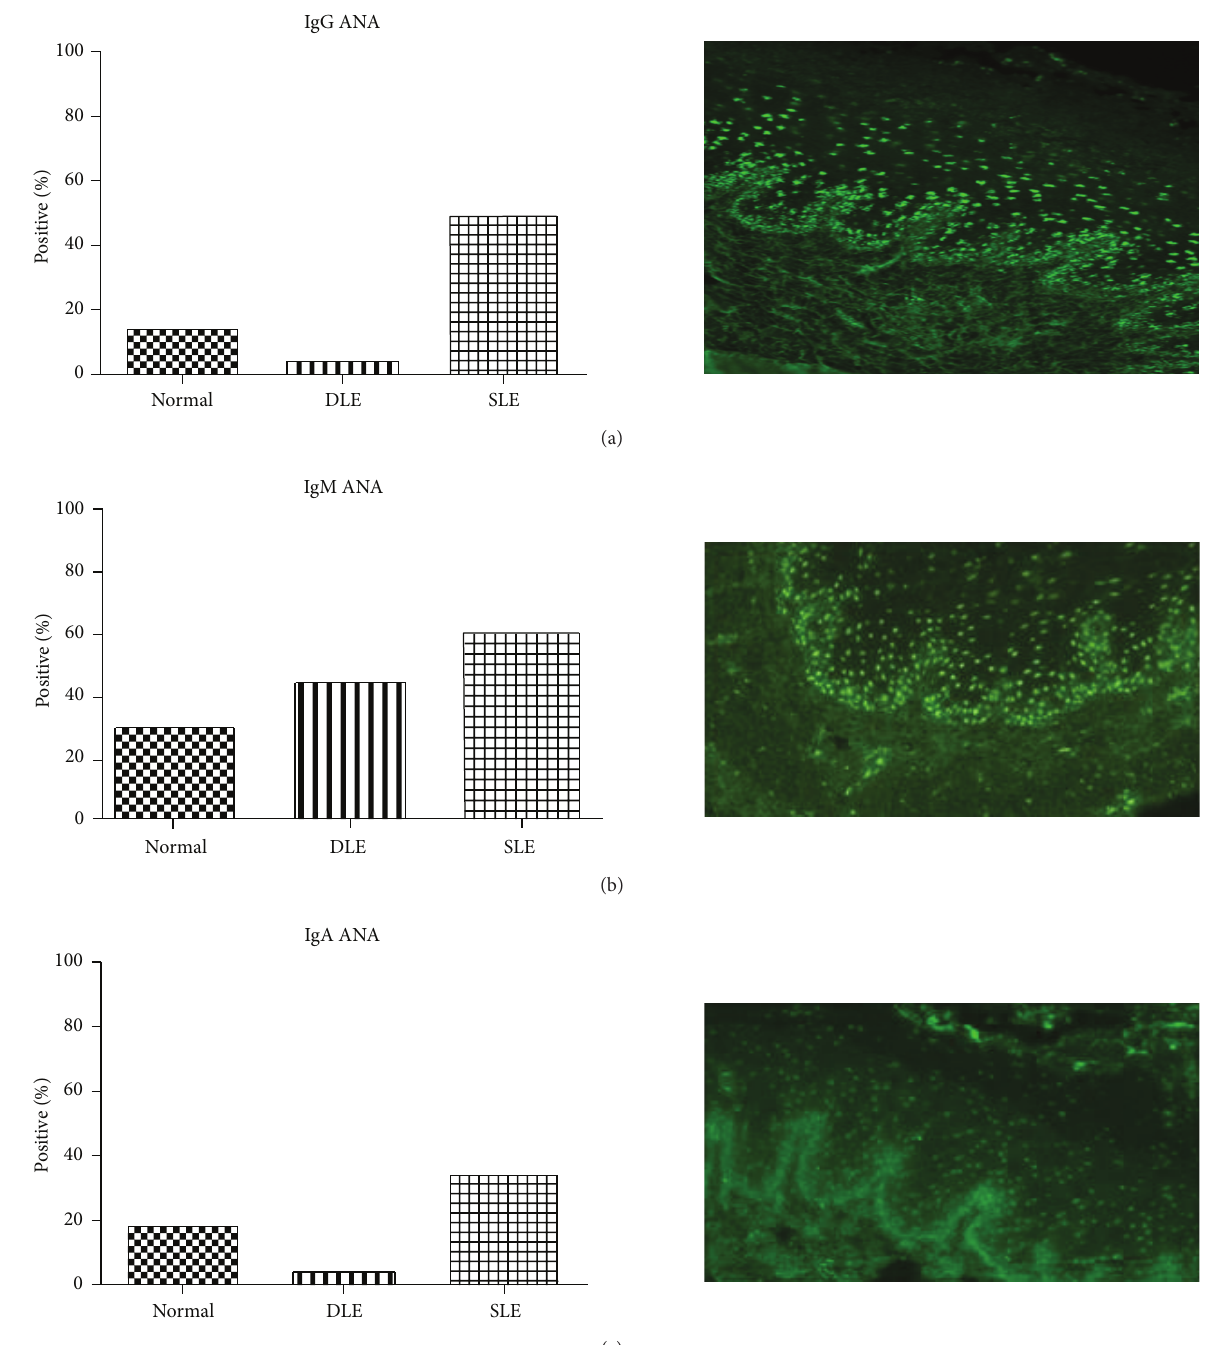
Figure 2: Higher percentages of positive ANAs were found in the SLE patient group by IIF. ((a)–(c)) Percentages of patients positive for IgG ANAs (a), IgM ANAs (b), and IgA ANAs (c) were calculated for normal, DLE, and SLE patient groups. There are missing IgM ANA data for three SLE samples due to insufficient quantities of sera. Examples of positive signals of IgG (a), IgM (b), and IgA (c) from SLE patients are shown. Objective: